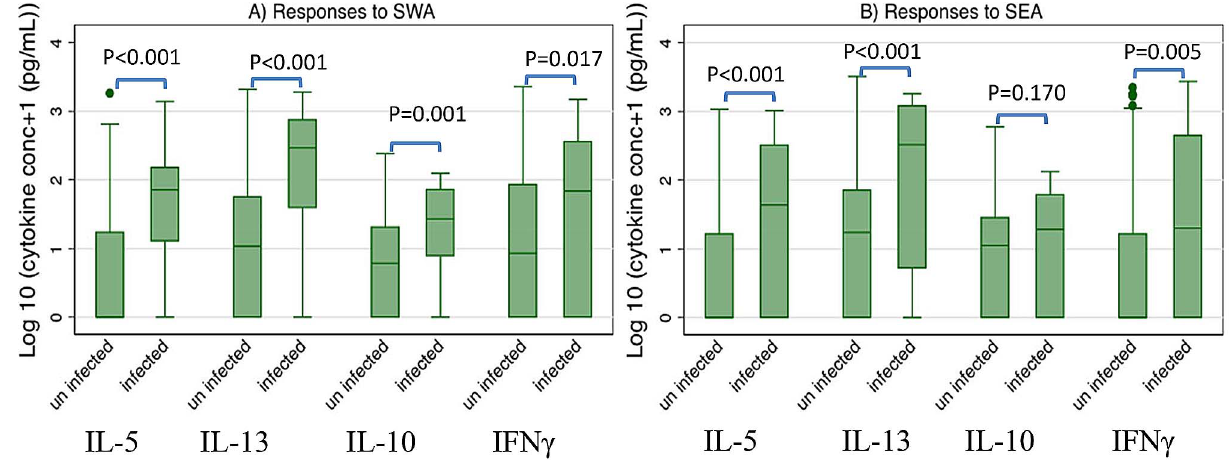
Figure 1. Cytokine responses to SWA (A) or SEA (B) among children at age five years. Comparisons are shown between uninfected children (n=390) and infected children (n=20). Presented are Wilcoxon rank-sum test